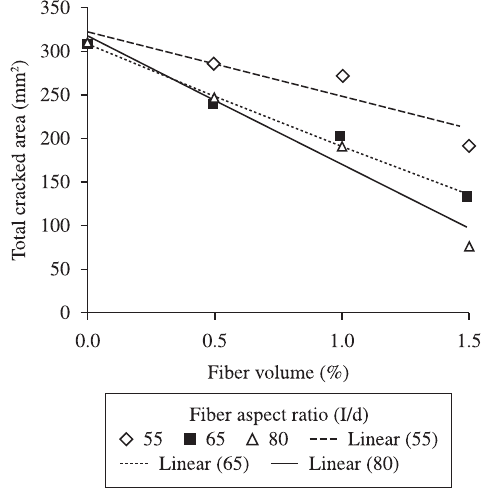
Figure 7. Total plastic shrinkage crack area as function of fiber volume (% by volume of concrete) for concrete series A.